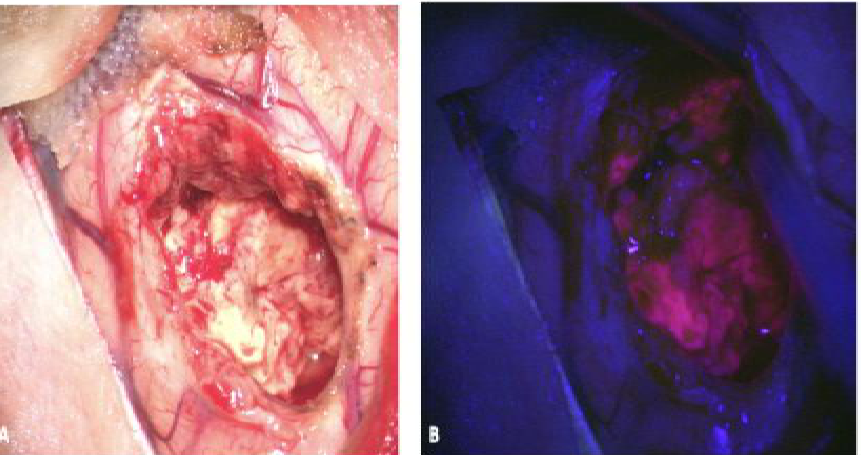
Figure 2. Fluorescence-guided surgery using 5-ALA for resection of a high-grade glioma. ( A ) shows the resection cavity under white light and ( B ) shows the red and pink fluorescence under blue light based upon tumor cell density, with the surrounding normal brain appearing blue without signs of fluorescence. 5-ALA, 5-aminolevulinic acid. (Permission from Hadjipanayis CG et al. Fluorescence Guided Brain Tumor Surgery. Youmans & Winn Neurological Surgery 8th Edition. Chapter 157B. New York: Elsevier; 2021) [21].